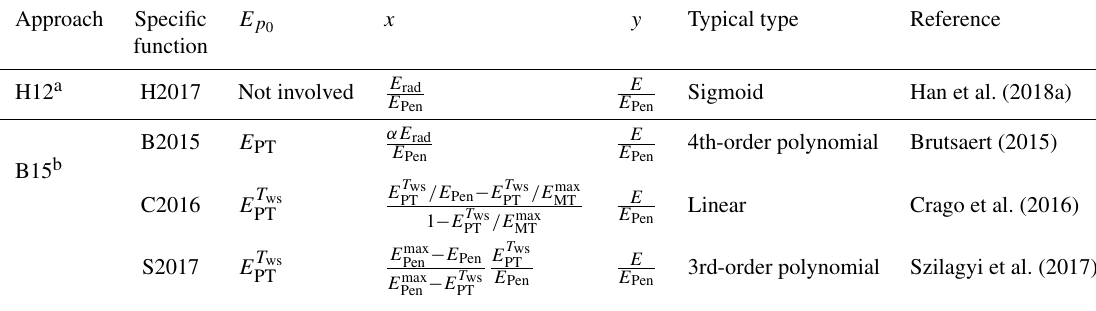
Table 3. Different forms of the generalized complementary function, y = f (x) . x y Typical type Reference Approach Specific E p 0 function E Sigmoid Han et al. (2018a) H12 a H2017 Not involved E rad E Pen E Pen E 4th-order polynomial Brutsaert (2015) E Pen Linear Crago et al.